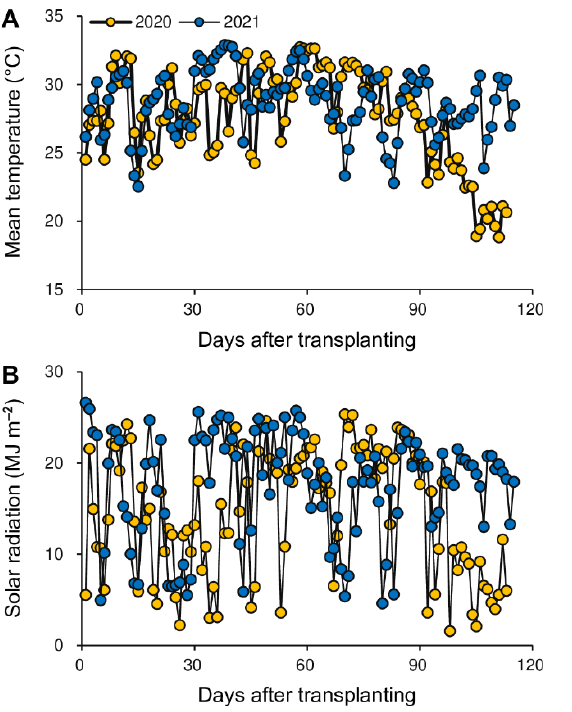
Figure 1. Daily mean temperature ( A ) and solar radiation ( B ) during the rice-growing season in 2020 and 2021.